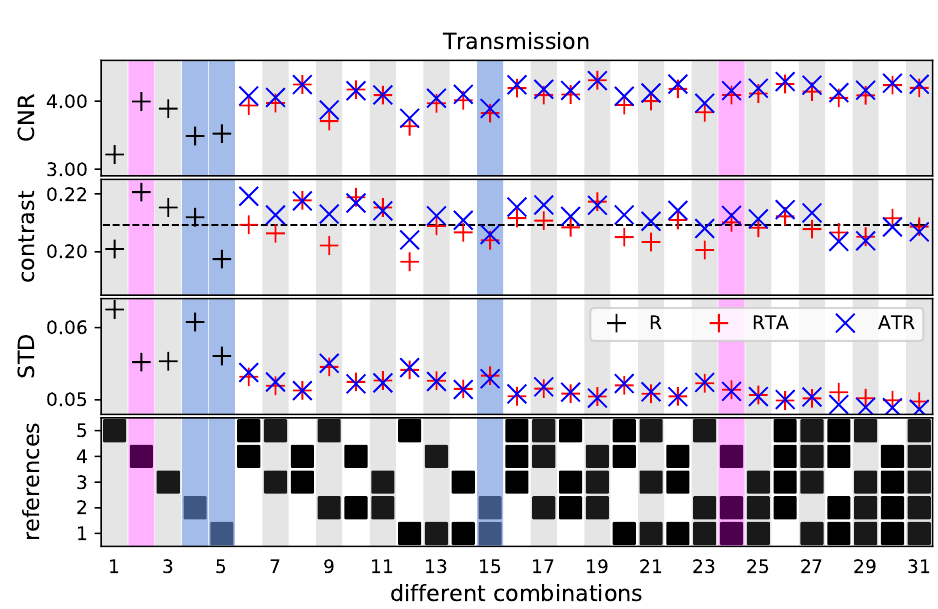
Figure 6. CNR, contrast and STD for the ROI of the transmission image, marked in Figure 2b. The STD and contrast values are given in values of relative transmission in percent. The plot in the last row indicates which reference images were used for deriving the values in the respective column. The red and blue markers show the results for the RTA and ATR, respectively. The black markers indicate the values if only one reference image is used. The black dashed line indicates the mean contrast of the first five combinations. The values in the colored columns are used for a detailed